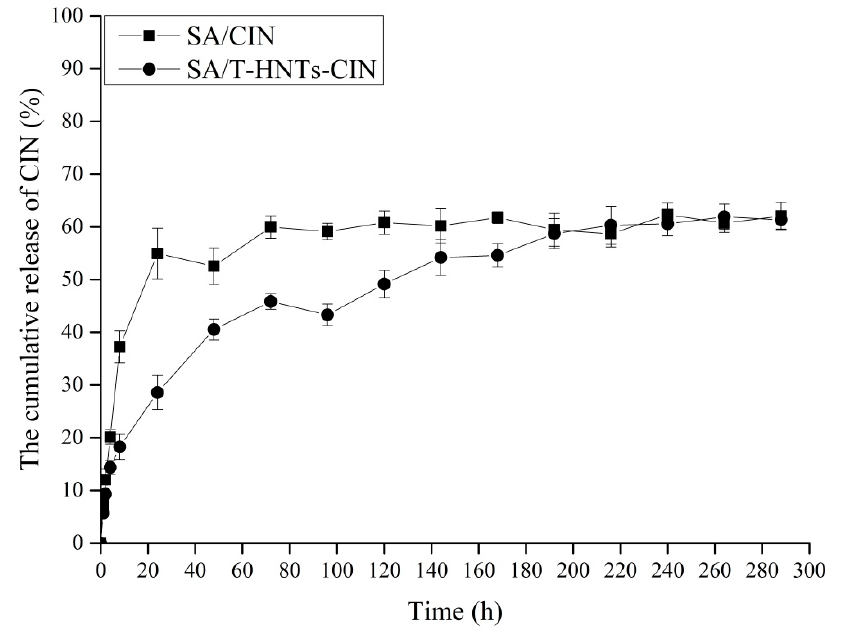
Figure 4. The cumulative release of CIN in the nanocomposite film: SA/CIN film and SA/T-HNTs-CIN film.